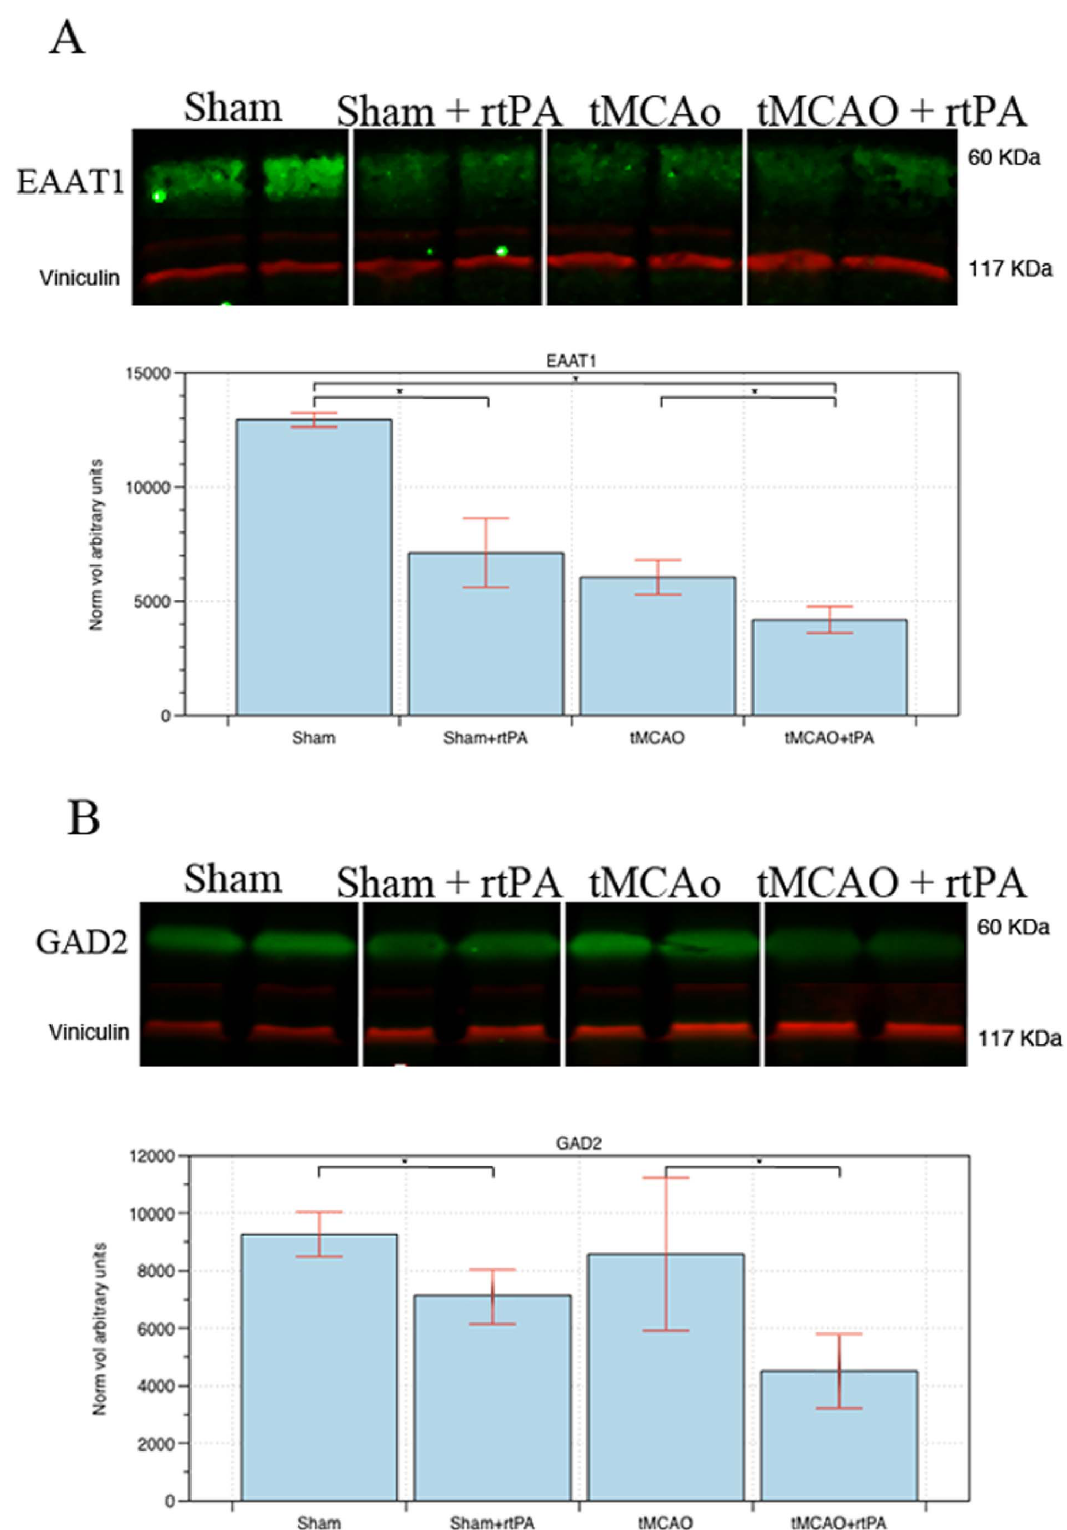
Figure 6. Quantification of protein expression by western blot. (A) Excitatory amino acid transporter 1 (EAAT1) and (B) Glutamate decarboxylase 2 (GAD2) expressions analyzed by western blot. Bands were quantified using scanned densitometry and normalized to viniculin expression. Vertical axis shows an arbitrary density unit. Asterisks mark significant changes (p , 0.05, n=4).